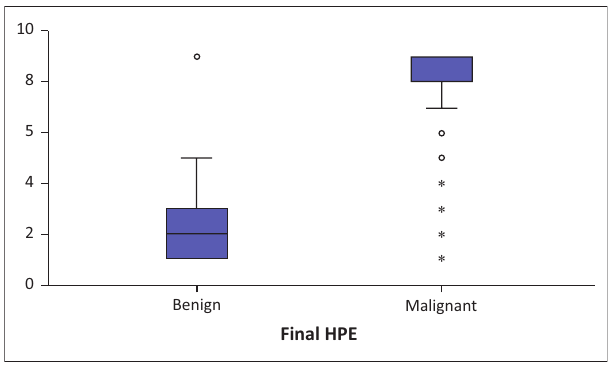
FIGURE 3: Box plot showing shear wave velocity in benign and malignant breast masses. TABLE 2: Distribution of elastography parameters between benign and malignant lesions. Elastography parameter